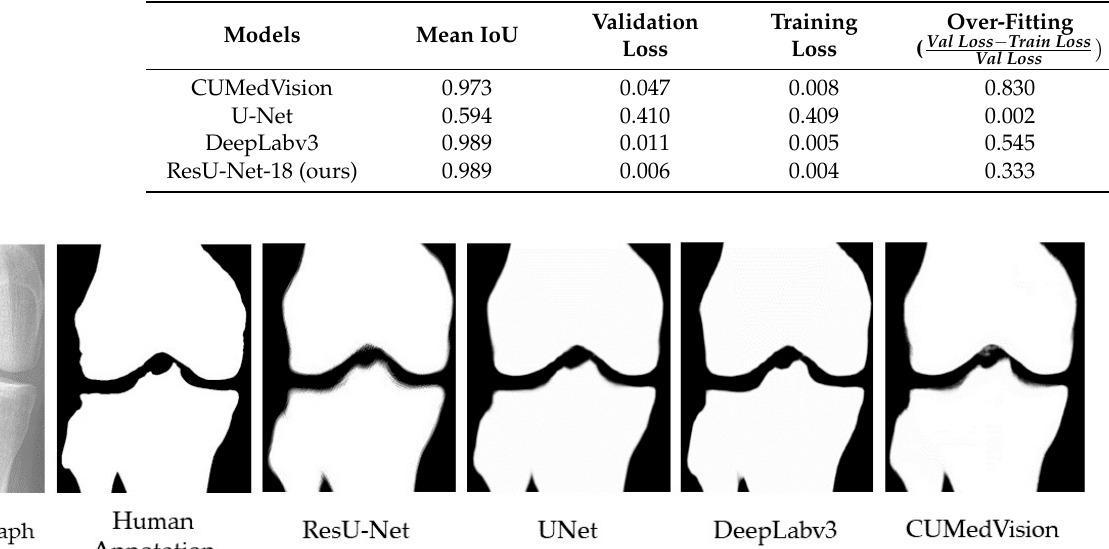
Table 1. Segmentation performance of different deep learning models.